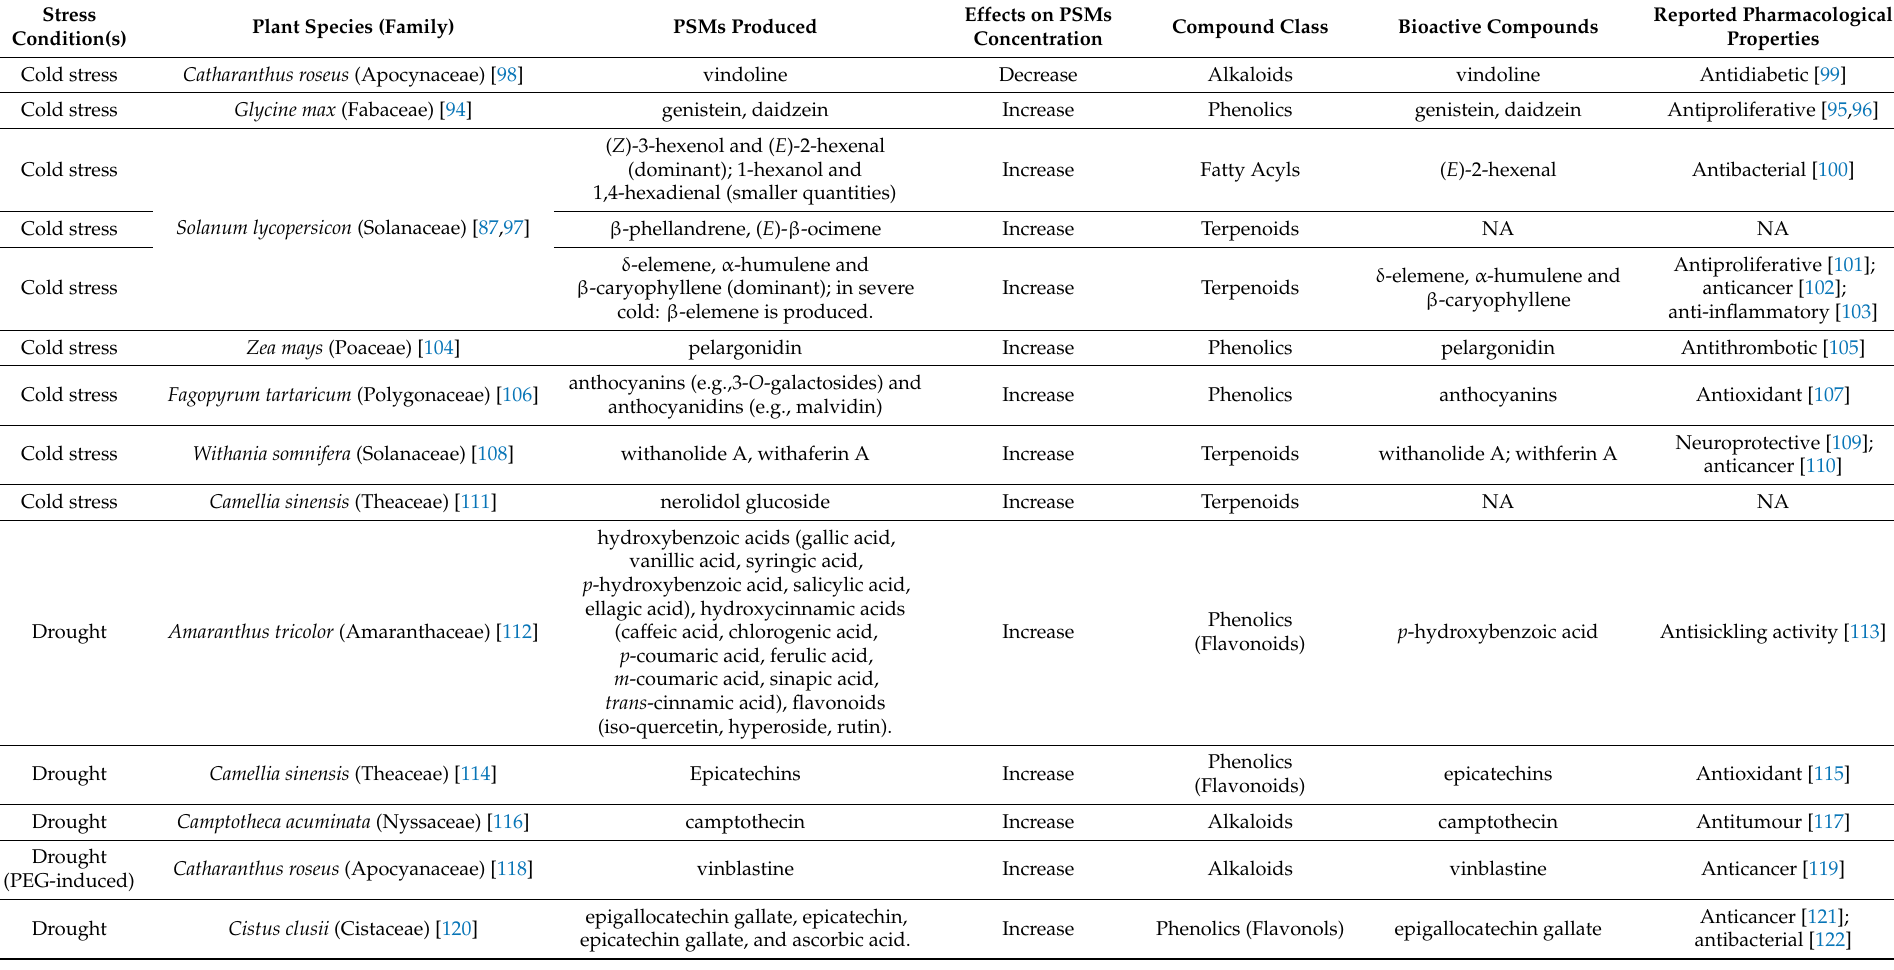
Table 1. Plant secondary metabolites produced in response to abiotic stresses and their reported pharmacological